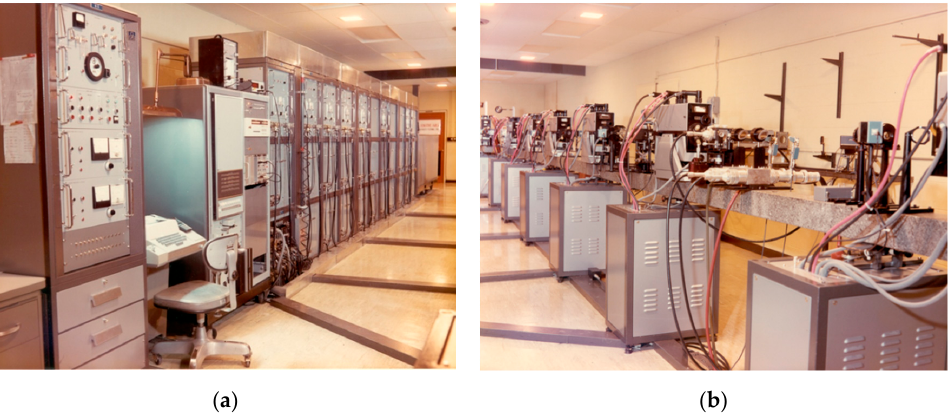
Figure 1. The Battelle Compagnie Gènèrale Electrique (CGE) VD-640 Q-switched laser became operational in 1970 and was used for laser shock investigations to the mid-1990s: ( a ) capacitor banks; ( b ) laser rod amplifiers.